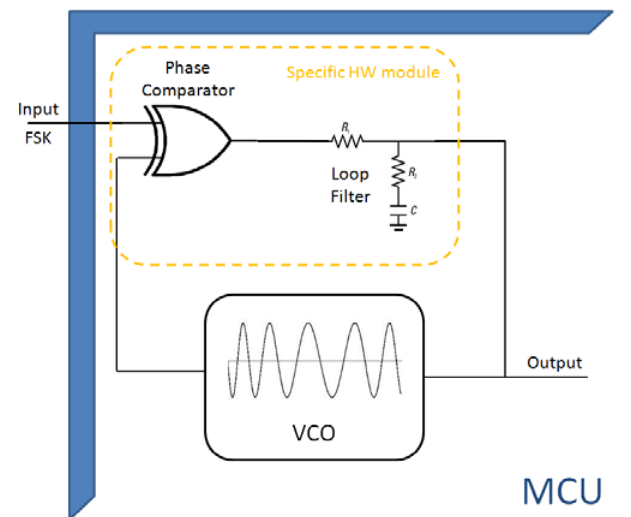
Figure 4. PLL block